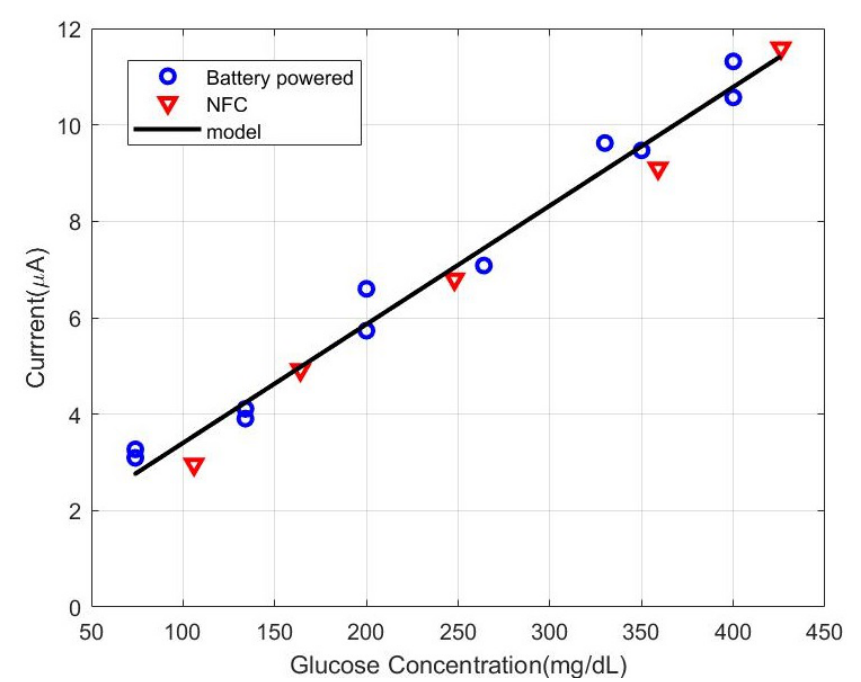
Figure 20. Measured current after 5 s as a function of glucose